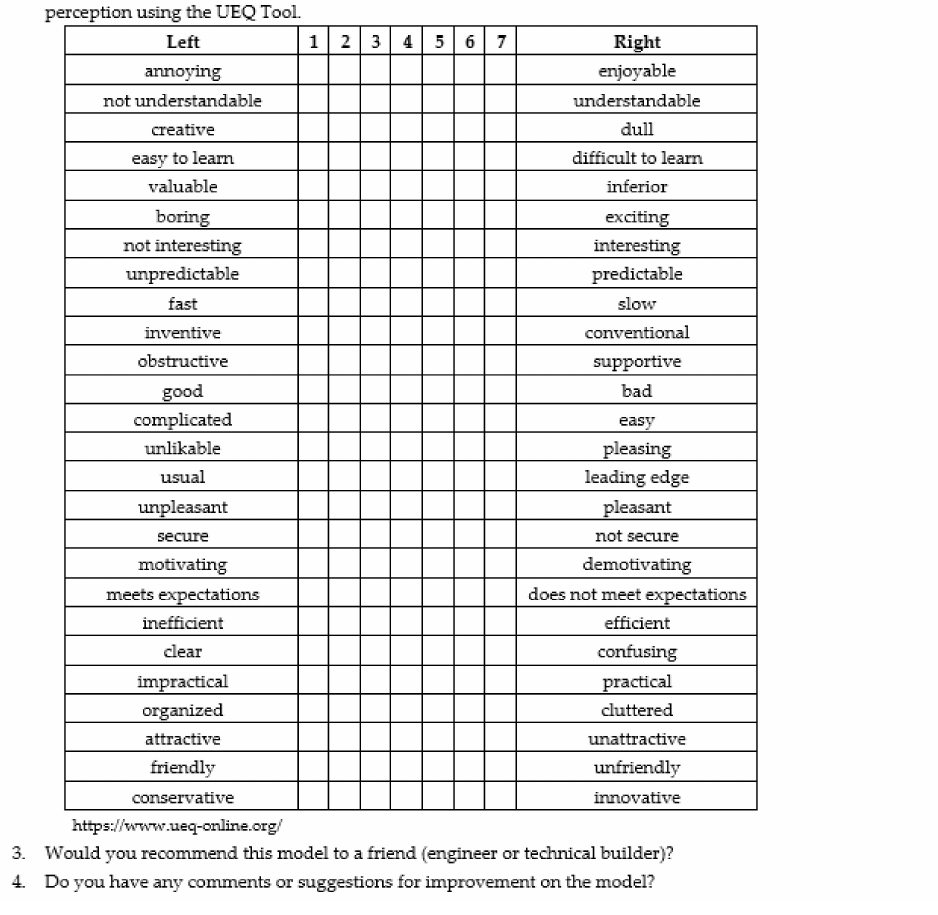
Figure A4. External users questionnaire—part 2. https://www.ueq-online.org/ (accessed